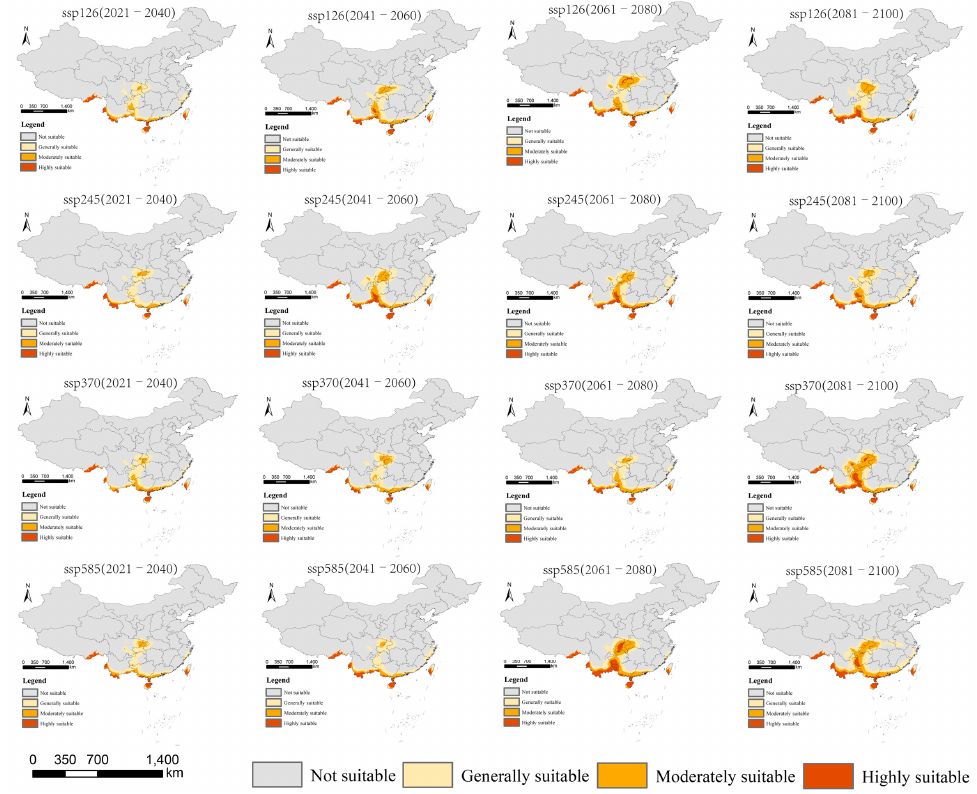
Figure 3. Potentially suitable areas for Anopheles philippinensis at the future climate scenarios using the MaxEnt model.